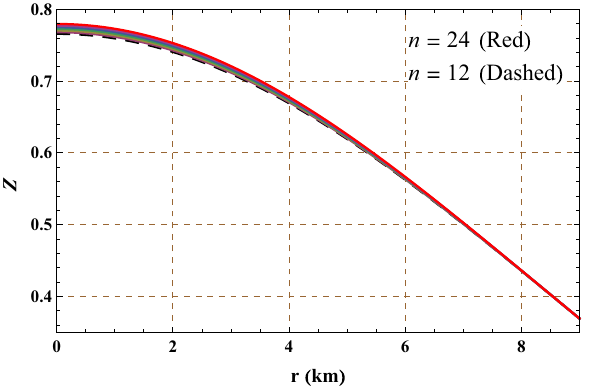
Fig. 6 Variation of redshift with radial coordinate for the parameters given in Table 1